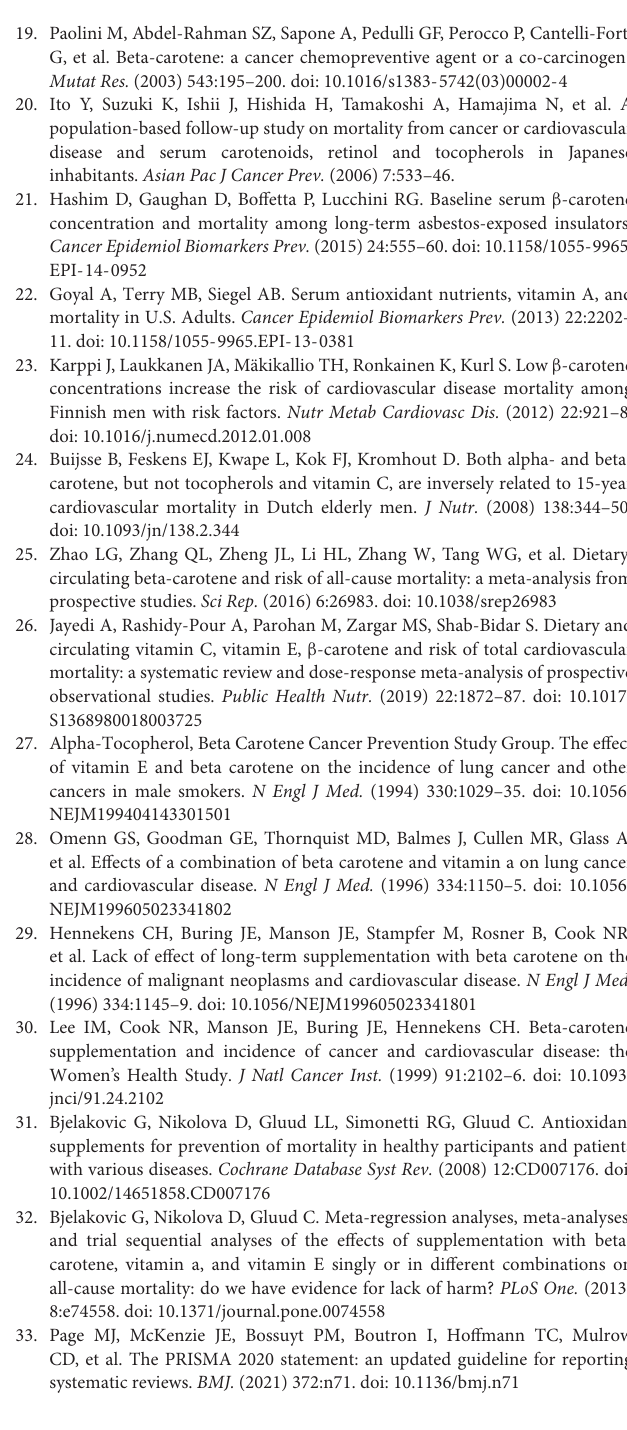
Supplementary Figure 5 | Subgroup analysis by the type of supplement (alone or in association). Supplementary Figure 6 | PRISMA checklist. Supplementary Figure 7 | Subgroup analysis by country. Supplementary Table 1 | Publication bias evaluation of each study by using the Cochrane Collaboration risk of bias